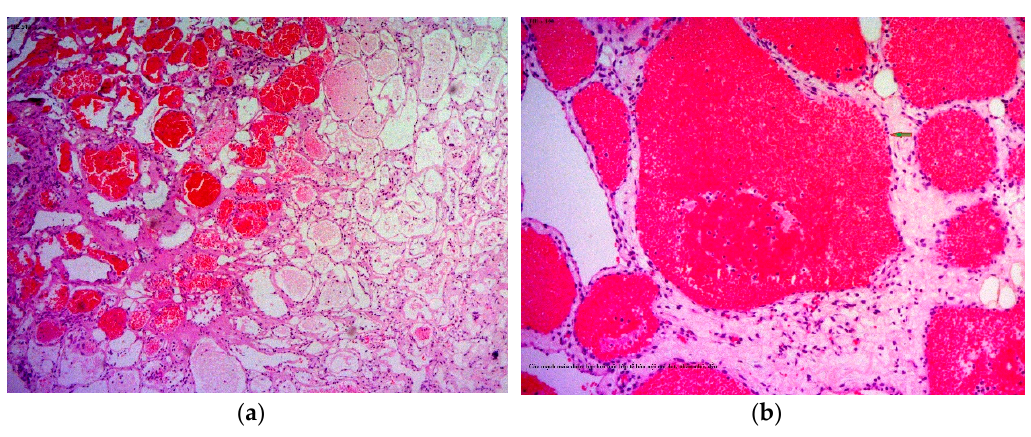
Figure 2. Histopathology revealing large numbers of thin-walled vascular sinusoids, with a single layer of endothelium-lined capillaries, and scanty connective tissue. ( a ) H&E, 100×; ( b ) H&E, 250×. H&E, hematoxylin and eosin.